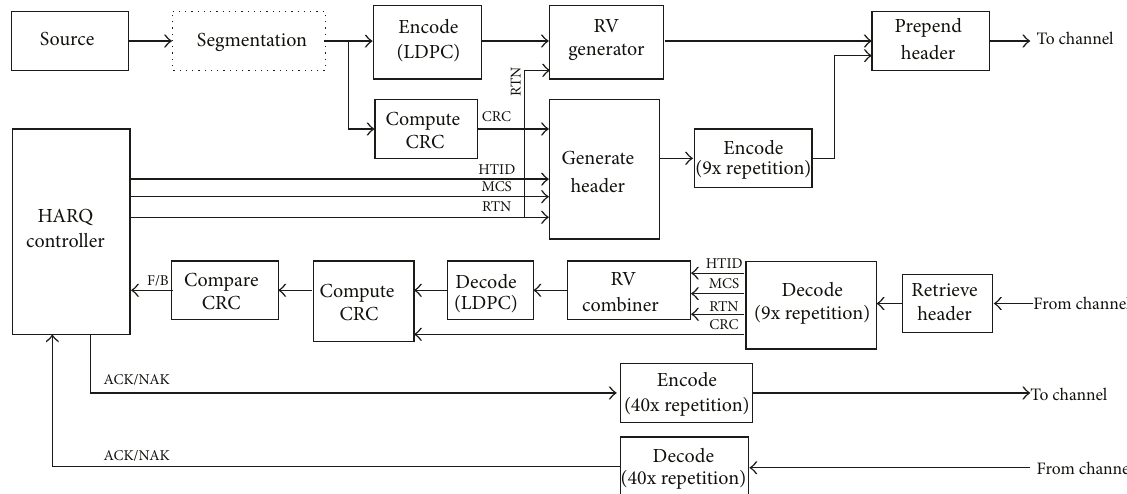
Figure 12: HARQ system schematic for one node. Overall, the system simulation uses two nodes (BS and